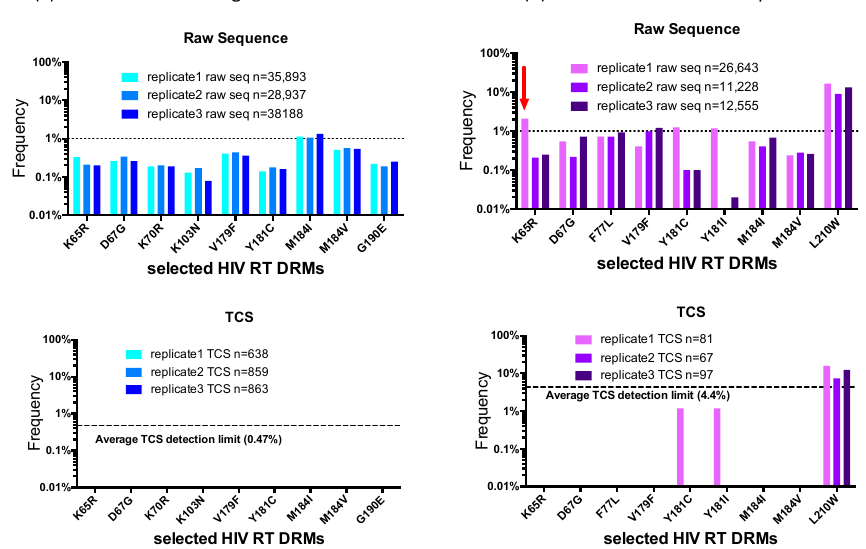
Figure 2. Comparison of Selected HIV-1 DRMs In the RT Region Analyzed Using Raw Sequence Reads or Template Consensus Sequences (TCS) Created Using Primer ID. ( a ) Sequencing of defective HIV-1 RNA from homogenous 8E5 virus. Top panel, analysis of DRMs in the raw sequence reads with the number of reads from triplicate sequencing runs shown (color coded); bottom panel is the same data analyzed using the Primer IDs in the data set to create TCS, with the number of TCS in each of the replicates shown. The dashed line in the top panel is an arbitrary 1% cutoff often used for reporting minor variants. The dashed line in the bottom panel is the average sampling depth (95% confidence of detection) for each of the triplicate sequencing runs. DRMs detected in the raw reads are shown. ( b ) Sequencing of HIV-1 RNA from a clinical specimen. These two panels are set up the same as in ( a ) with the lesser number of TCS in the data set indicated in the low panel and thus the reduced sensitivity of detection (dashed line).